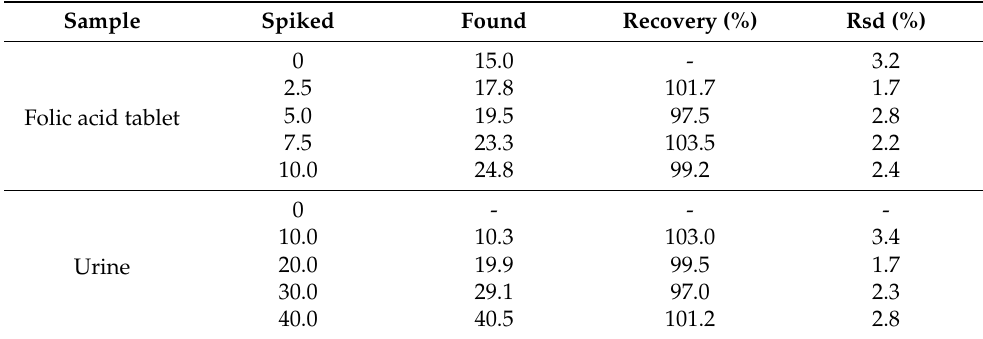
Table 8. Determination of FA in FA tablet and urine samples. All the concentrations are in µ M (n = 5)